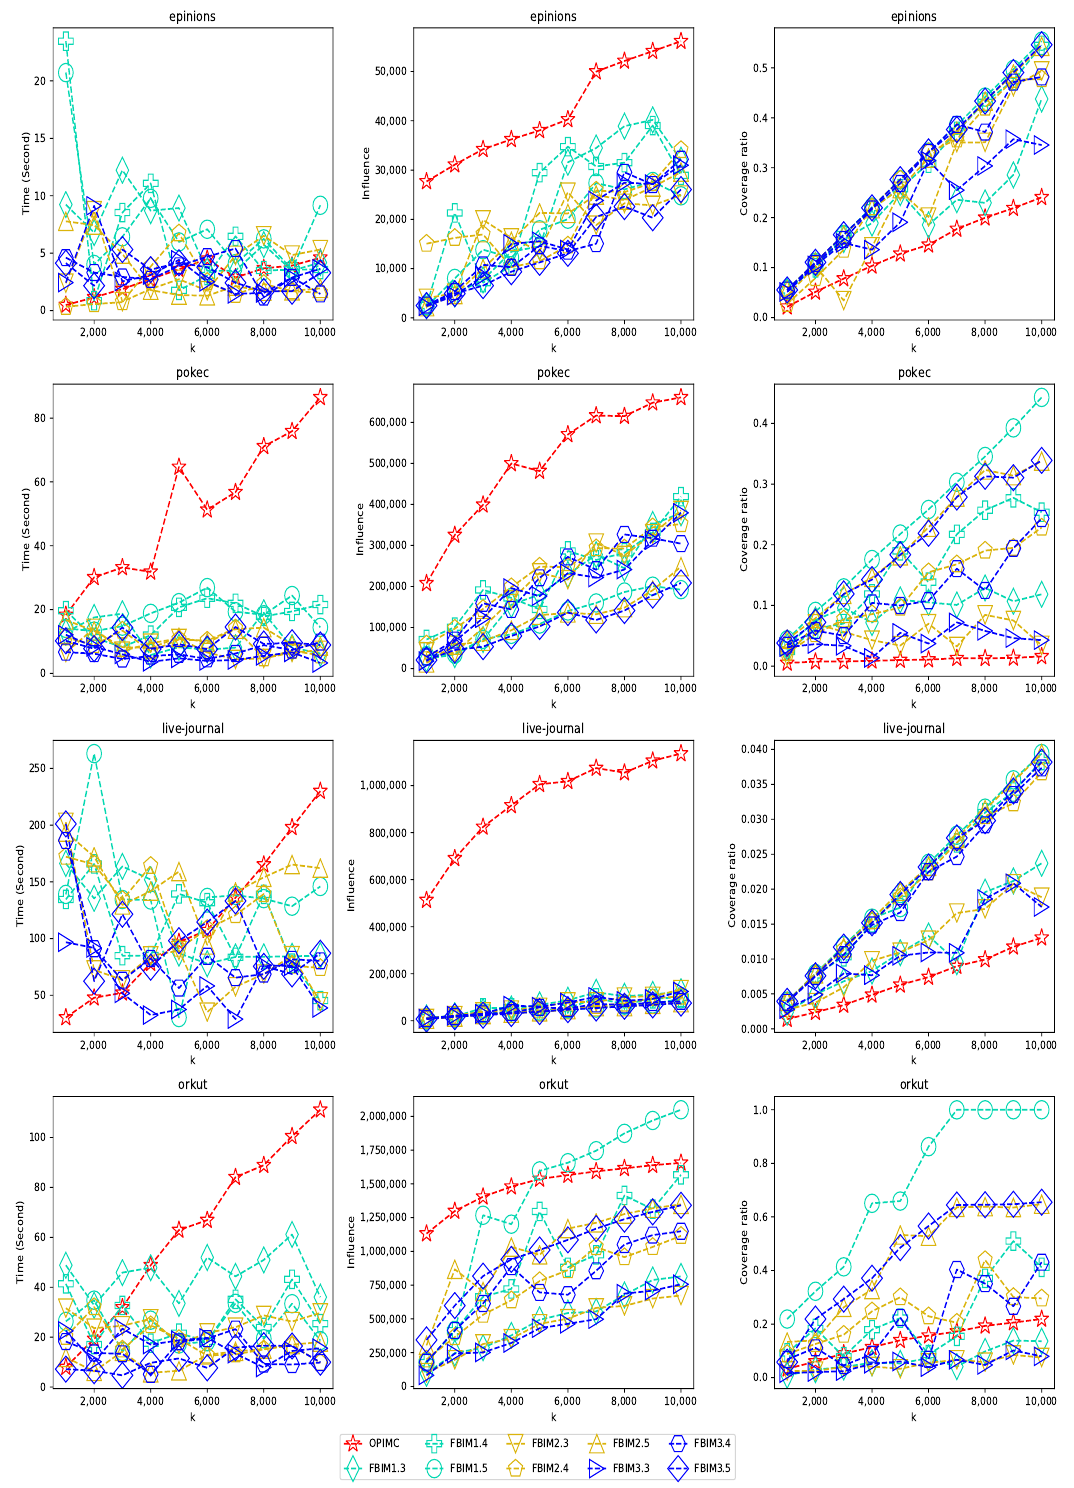
Figure 3. Running time, influence, and coverage ratio for Experiment 2 under the LT